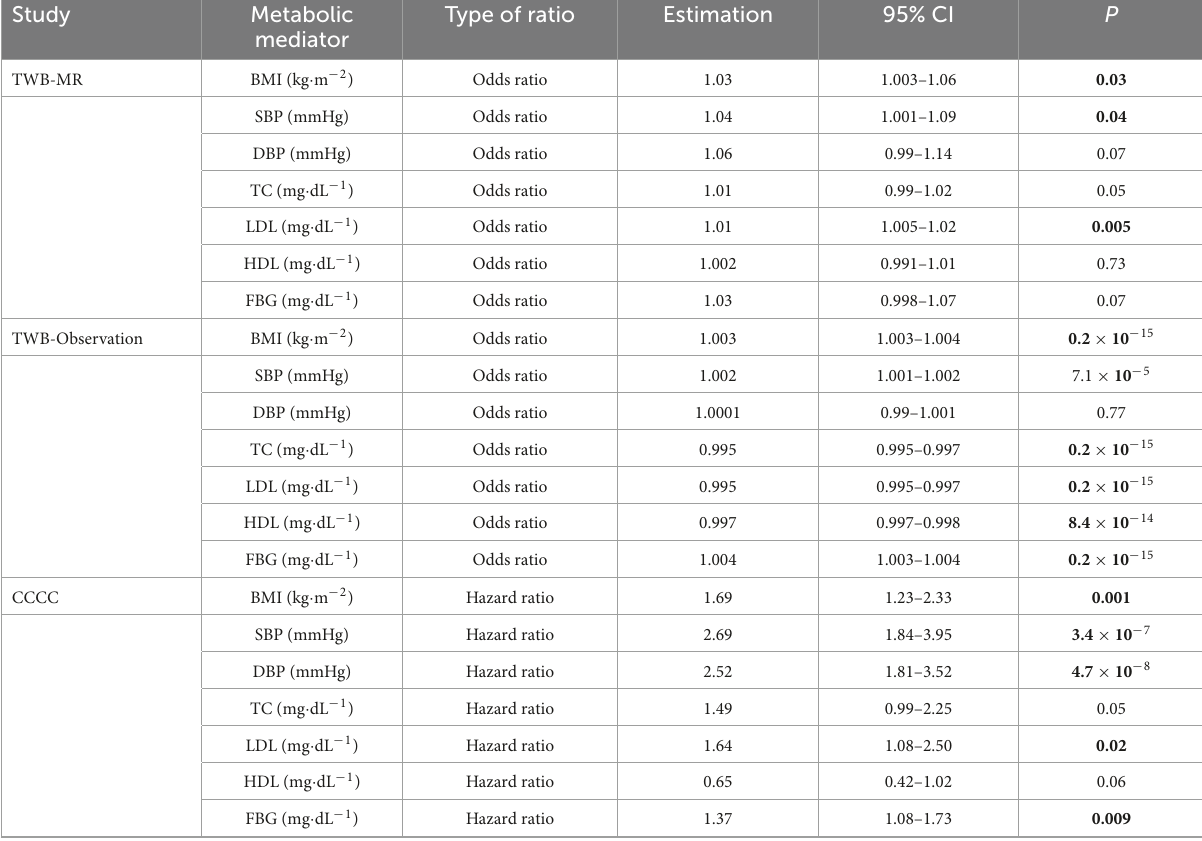
TABLE 4 Effects of one standard deviation mediator on the risk of coronary artery